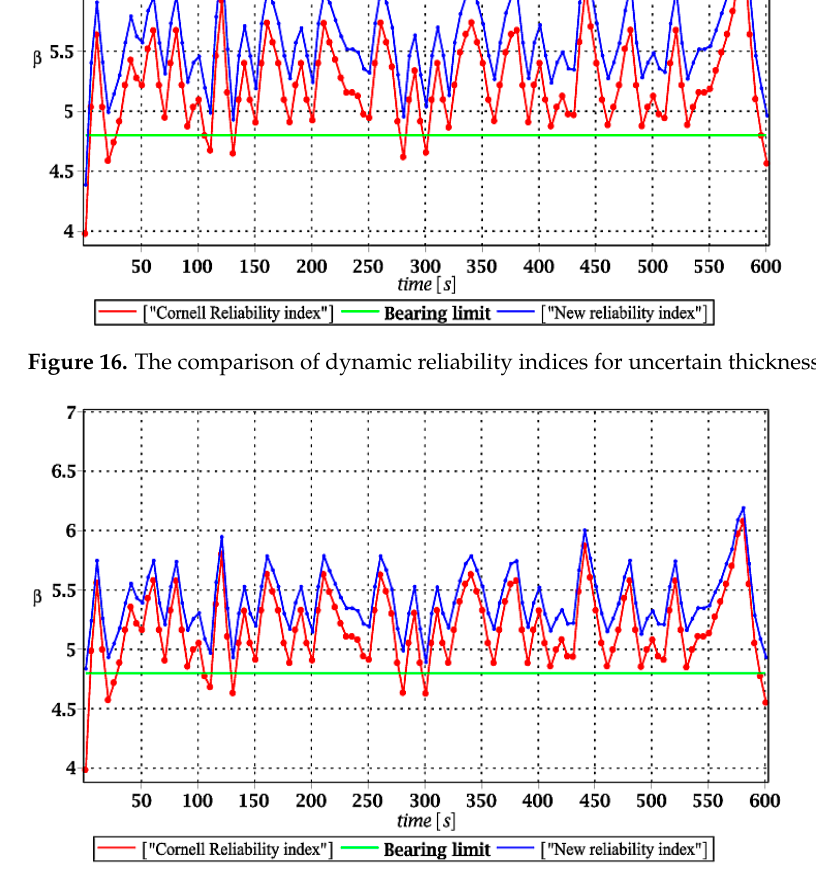
Figure 17. The comparison of dynamic reliability indices for uncertain wind pressure.